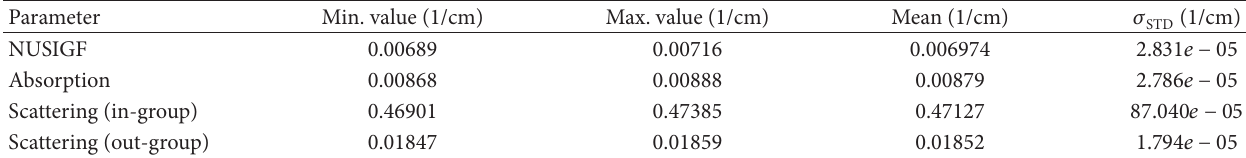
T 8: Uncertainty analysis of homogenized macroscopic cross-sections (fast group,